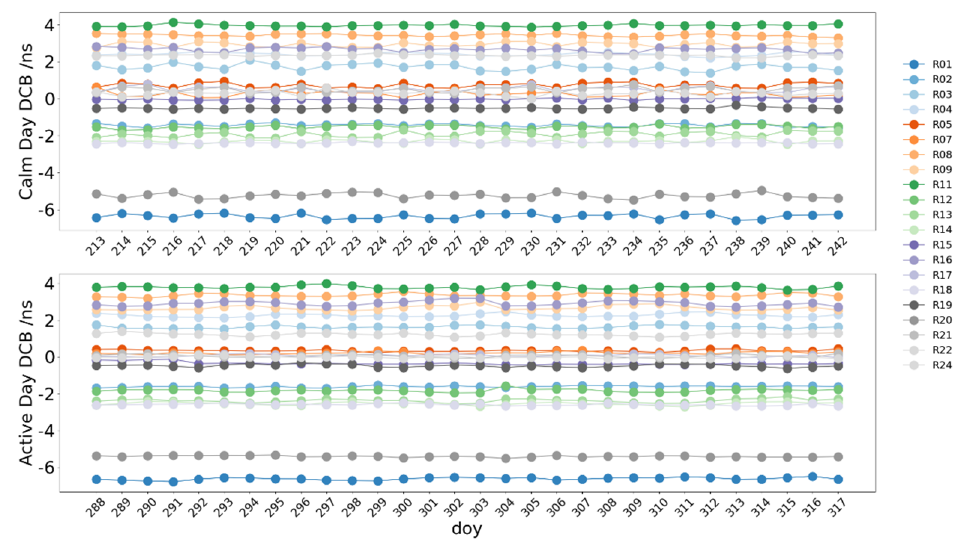
Figure 11. DCB time series of GPS satellites at different ionospheric conditions.